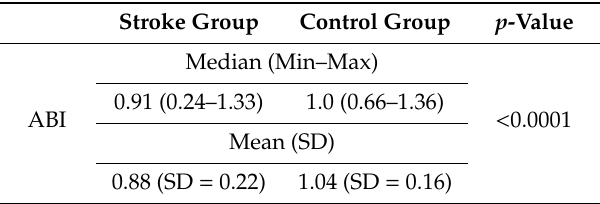
Table 4. ABI values in the stroke and control